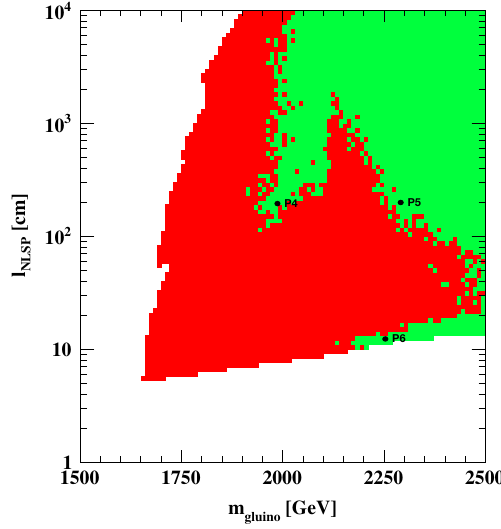
Fig. 6 Exclusion limits in the DGSU model obtained with CheckMATE2 . Red (green) points are excluded (allowed) by direct SUSY searches at the LHC. Also shown are the benchmark points P4- P6 of Table